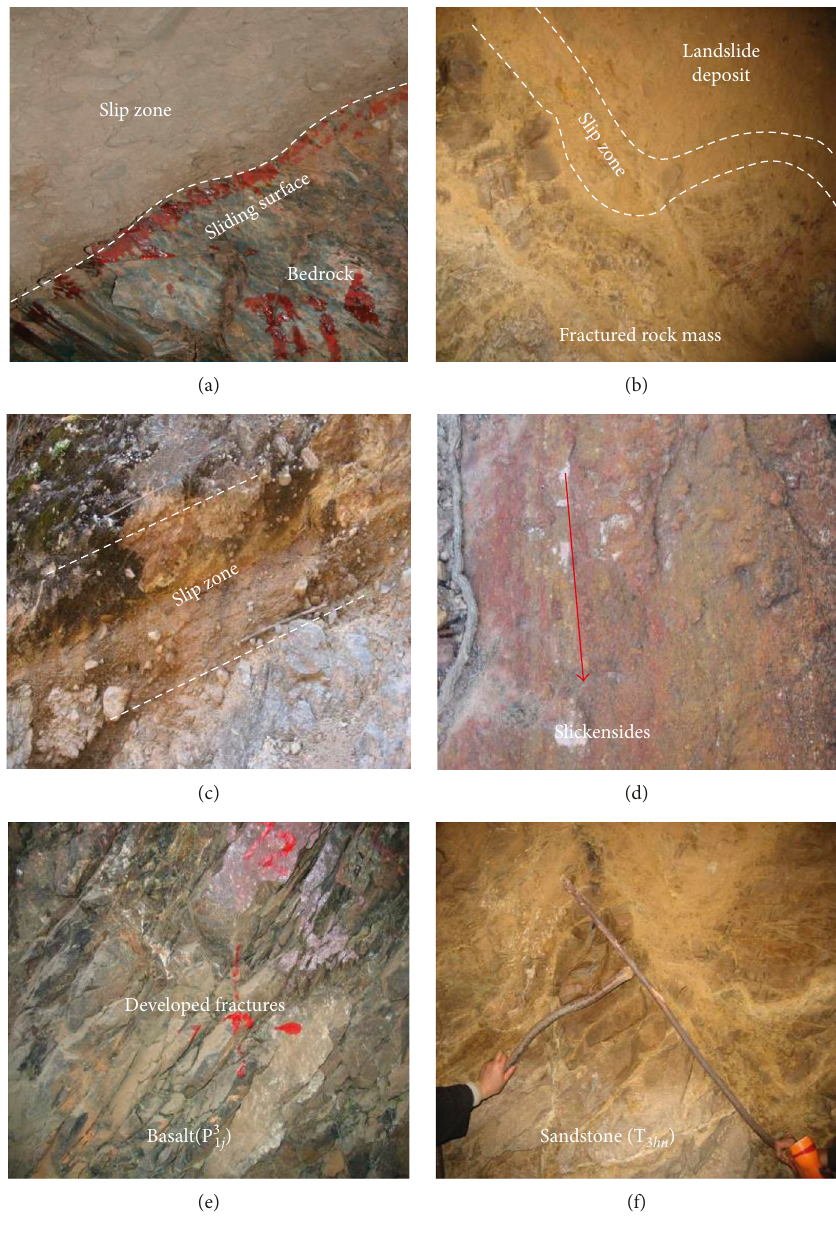
Figure 6: Slip zones and